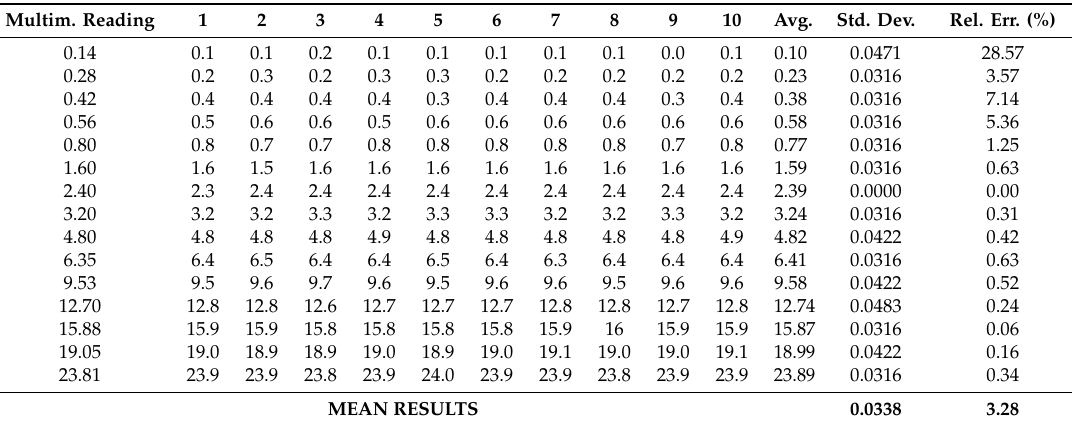
Table 4. Measurements corresponding to the metering validation (all values in amperes). Multim.